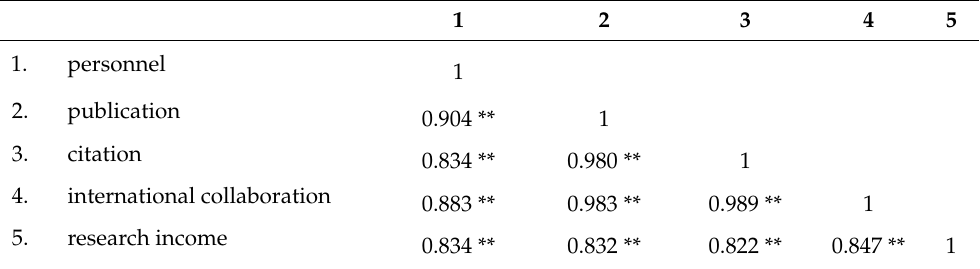
Table 4. Correlation analysis.